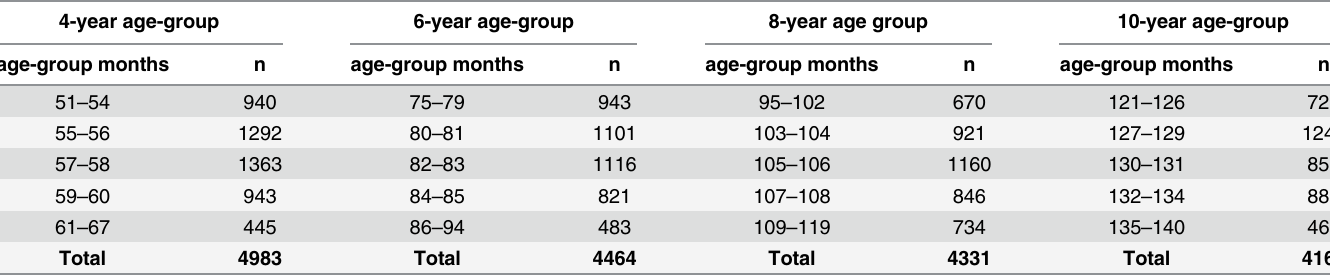
Table 2. Age-groups within the 4-year, 6-year 8-year, and 10-year age-groups. 4-year